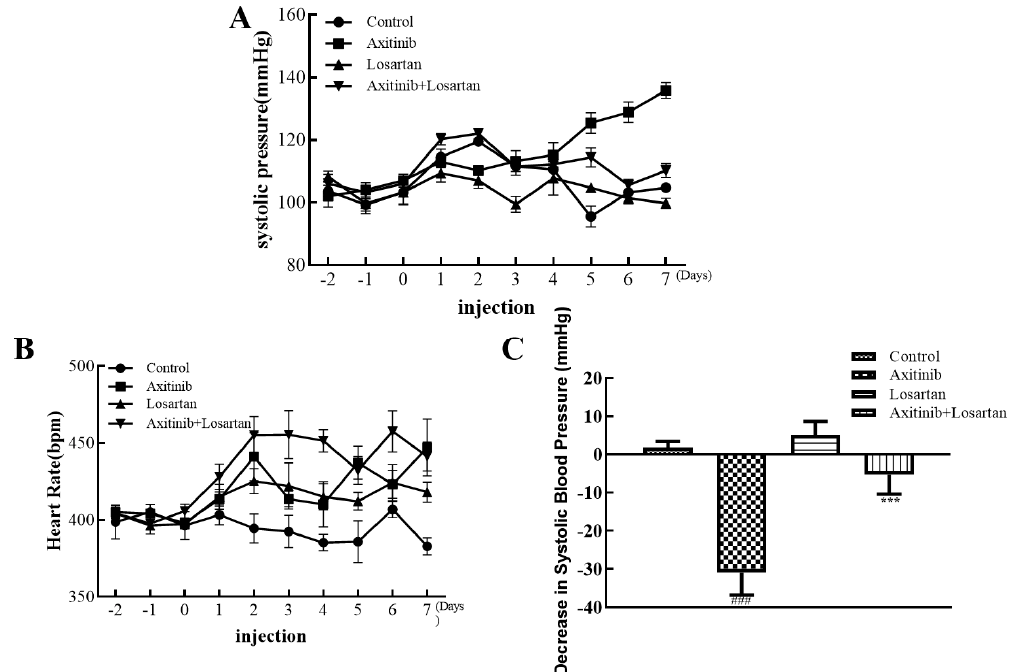
Figure 1. Effects of axitinib combined with losartan on systolic blood pressure and heart rate in rats. ( A ) Effects of axitinib combined with losartan on systolic blood pressure. ( B ) Effects of axitinib combined with losartan on heart rate. ( C ) The decreasing level of systolic blood pressure of rats in each group on the 7th day. ### p < 0.001 vs. control. *** p < 0.001 vs. axitinib.